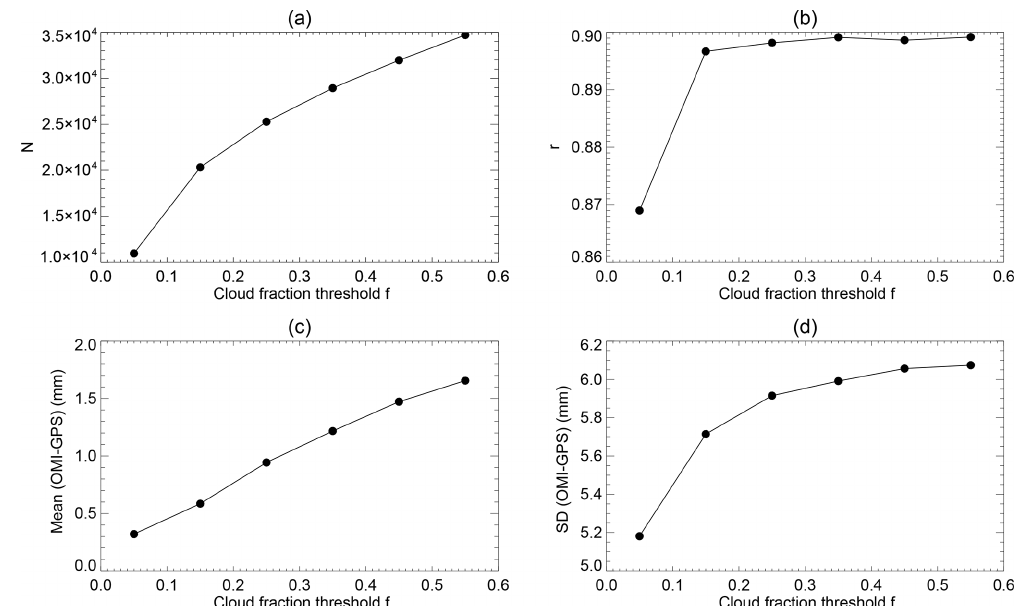
Figure 3. Dependence of various parameters on the cloud fraction threshold ( f ) used for filtering OMI data. Other filtering criteria remain the same as those for Fig. 2. The parameters are (a) the number of colocated OMI and GPS data pairs; (b) the linear correlation coefficient between OMI and GPS TCWV; (c) the mean of OMI–GPS in millimeters; and (d) the standard deviation of OMI–GPS in millimeters. Results are derived from the colocated version 4.0 OMI and GPS data for the whole year of